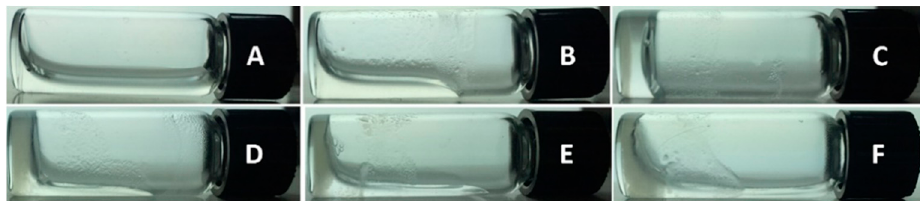
Figure 2. Optical images of 0.4 wt% NapFFDALDLTD ( 4 ) in water ( A ) without or with the addition of ( B ) 0.5, ( C ) 1, ( D ) 2, ( E ) 3 and ( F ) 4 equiv. (molar ratio) AcKKFKLKL ( 1 ) in water, after 5 days.